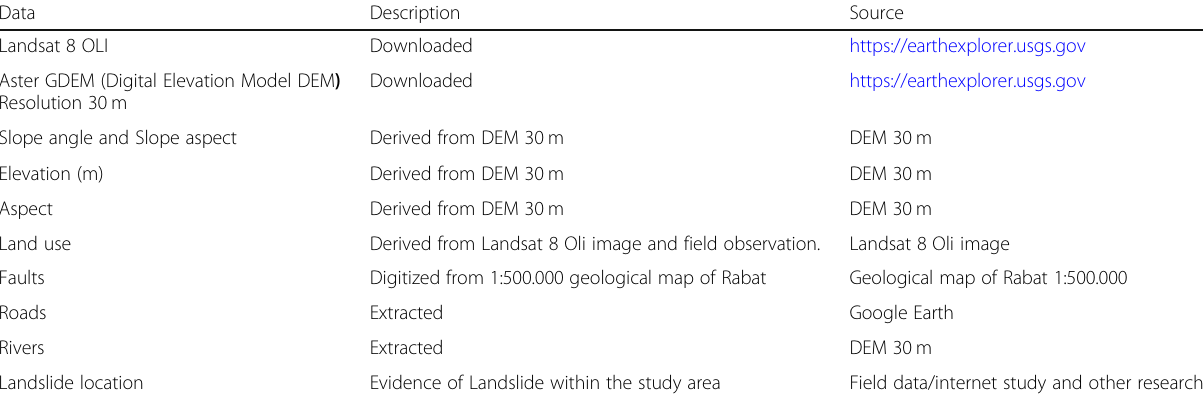
Table 1 Sources of data used for the study